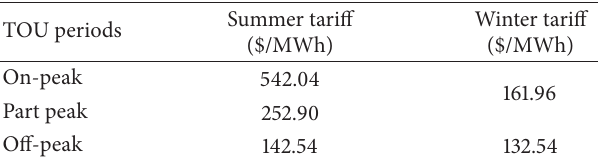
Table 2: TOU tariff